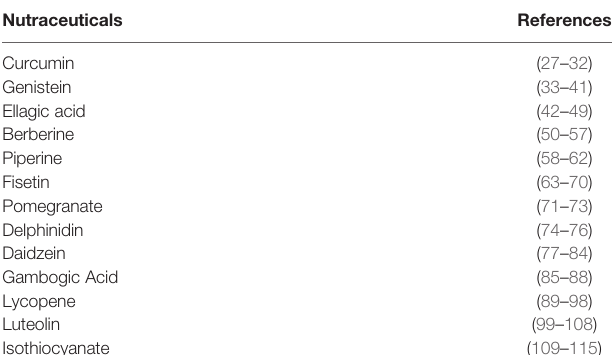
TABLE 1 | Tabulated data of studies showing nutraceuticals having anti prostate cancer activity.